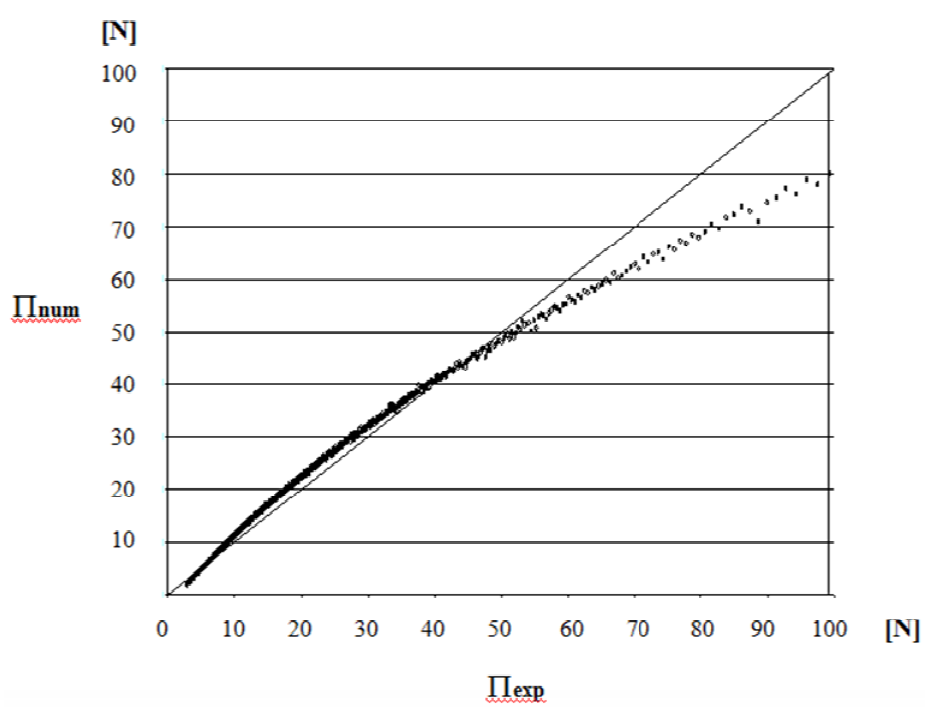
Figure 7. Comparison of the theoretical formula (3) (∏num) with experimental values